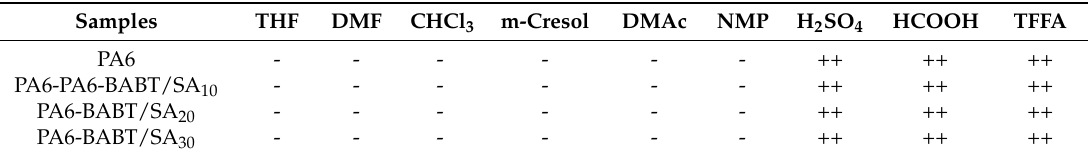
Table 6. Solubility of PA6 and PA6-BABT/SA